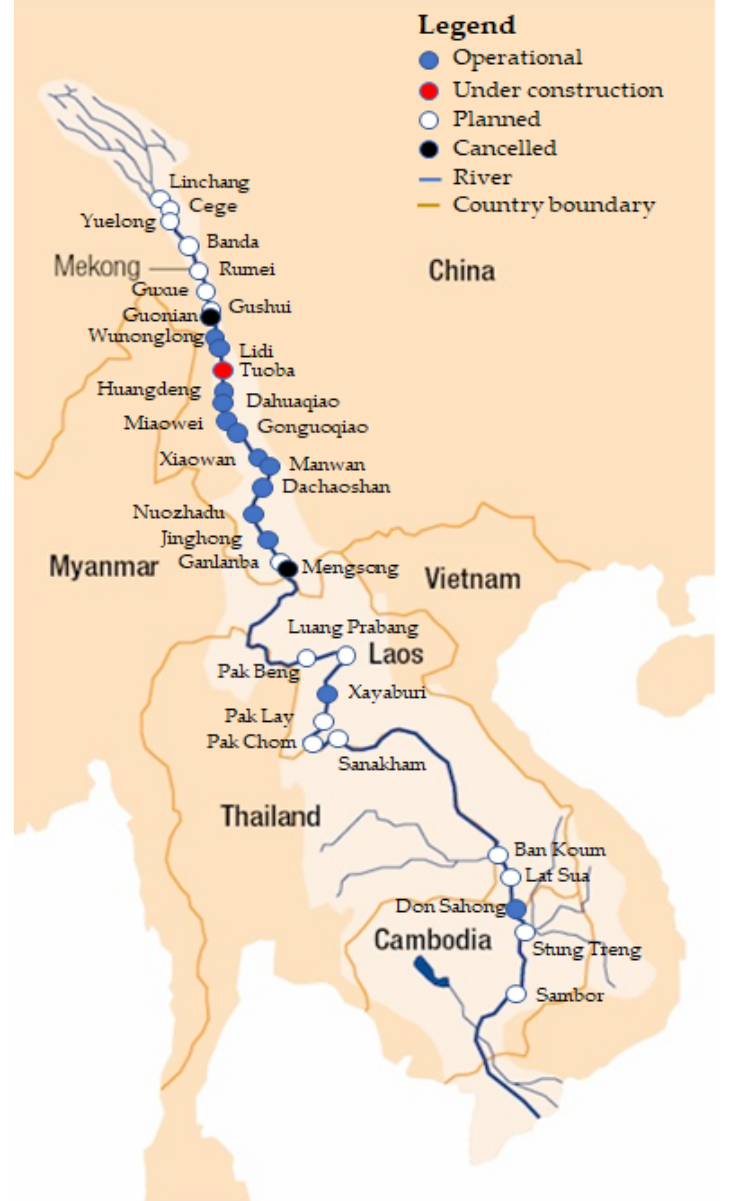
Figure 2. Current and planned hydropower dams in the Lancang-Mekong Basin [11,12,92].